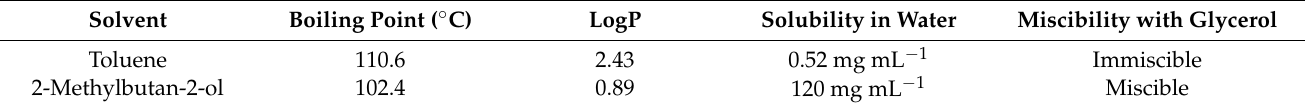
Table 1. Characteristics of the tested organic